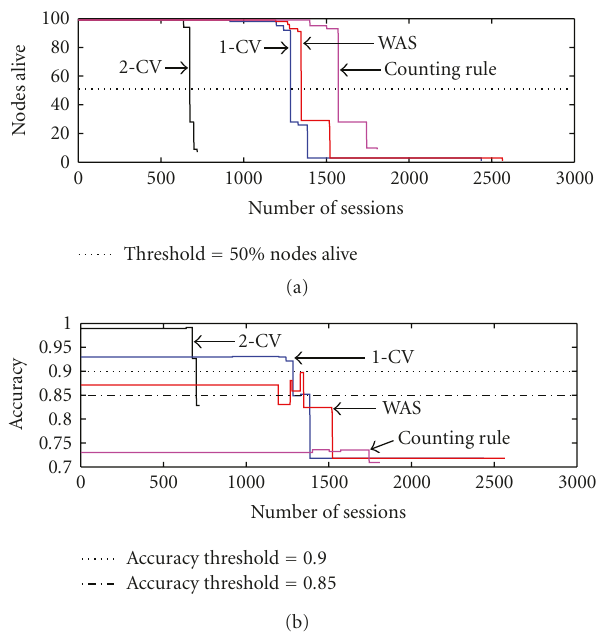
Figure 10: (a) Simulation results for network lifetime with respect to number of sessions for various aggregation schemes. (b) Numerical results of accuracy with respect to number of sessions for various aggregation schemes.